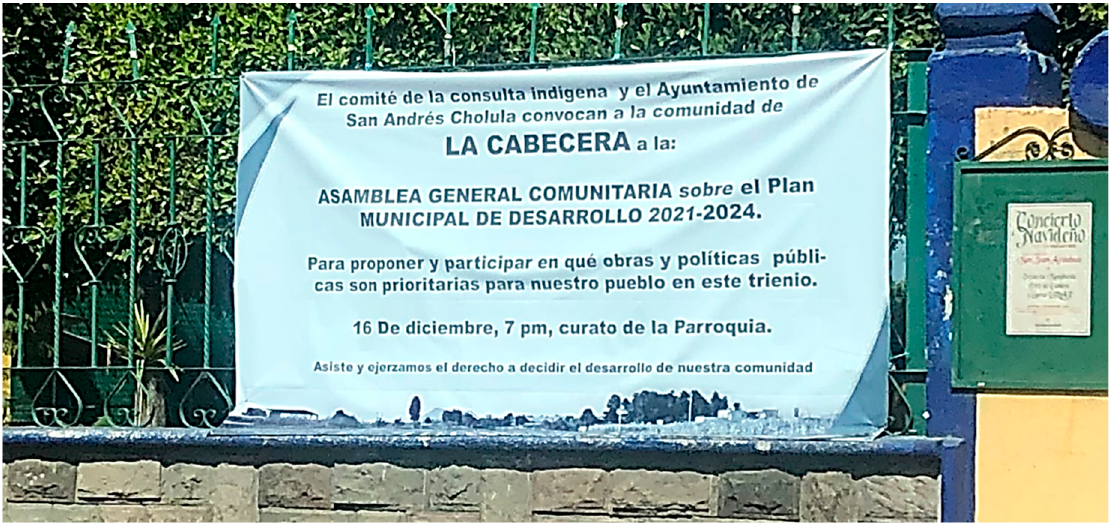
Figure 2. The general assembly call a consultation for the new municipal development plan of San Andrés Cholula. Billboard located in the church of San Juan Aquiahuac. Source: Guizar-Villalvazo, M. (2021).